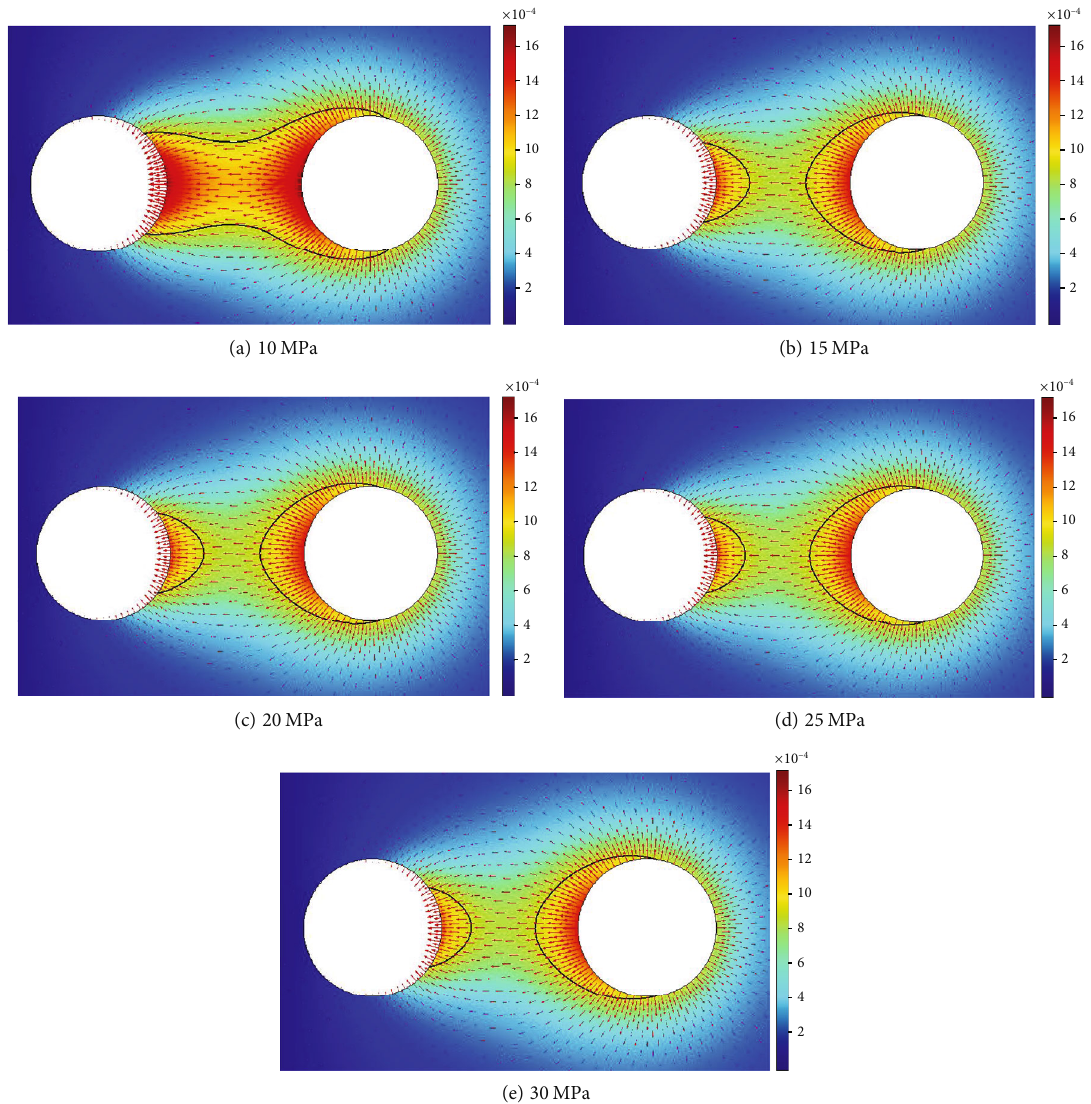
Figure 12: Velocity distribution of surrounding rock after excavation under di ff erent geostress (unit: